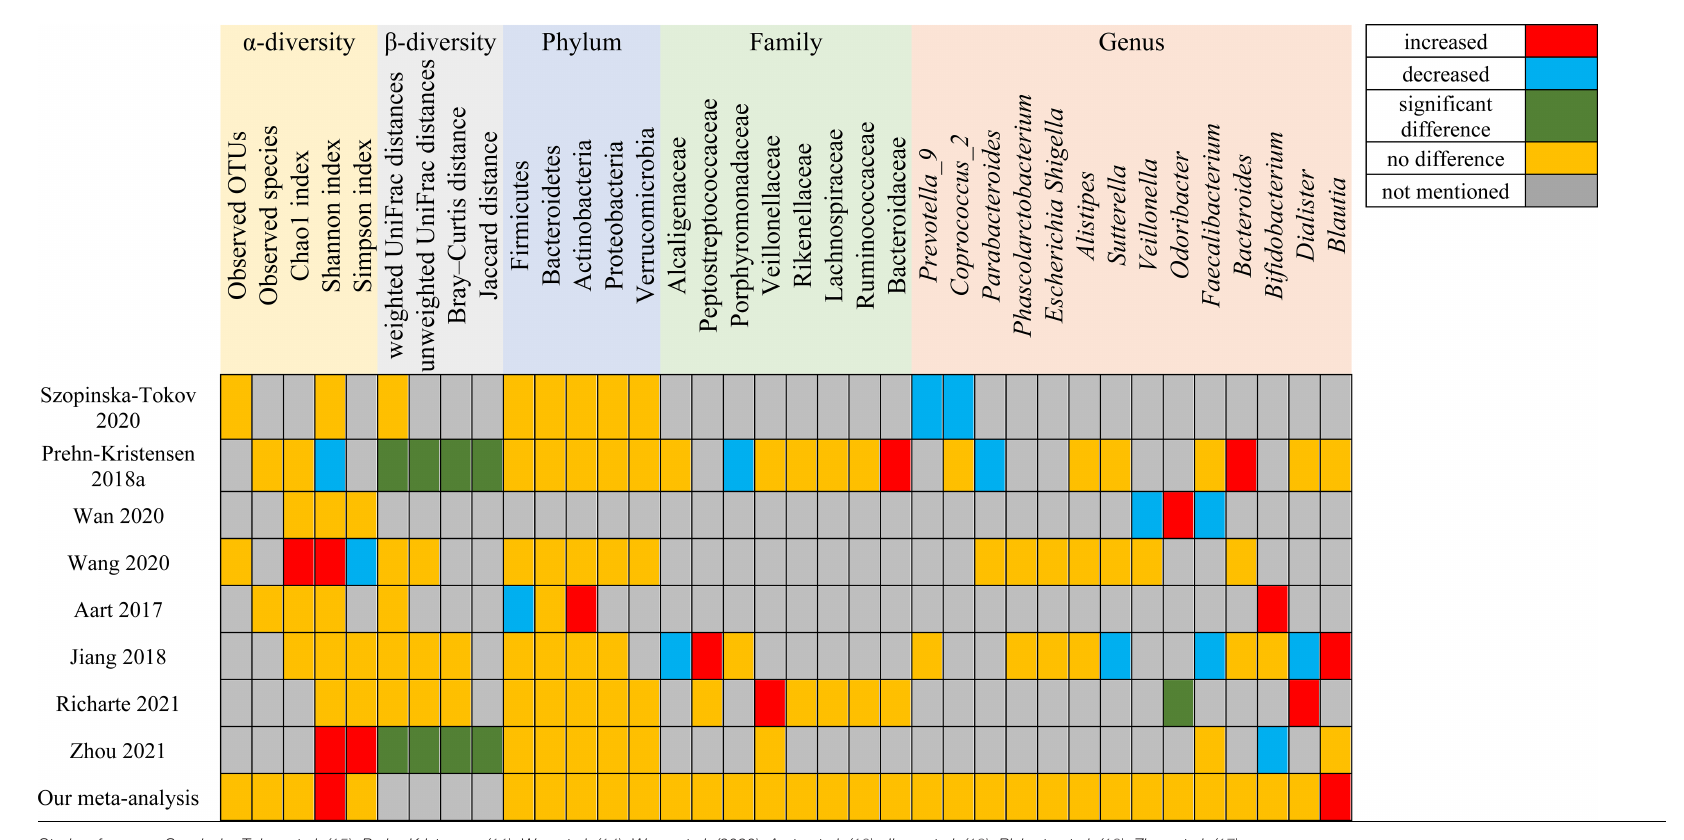
TABLE 4 | Summary of the outcomes of the included studies on microbiota pro fi les (alpha and beta diversity) and gut microbiota